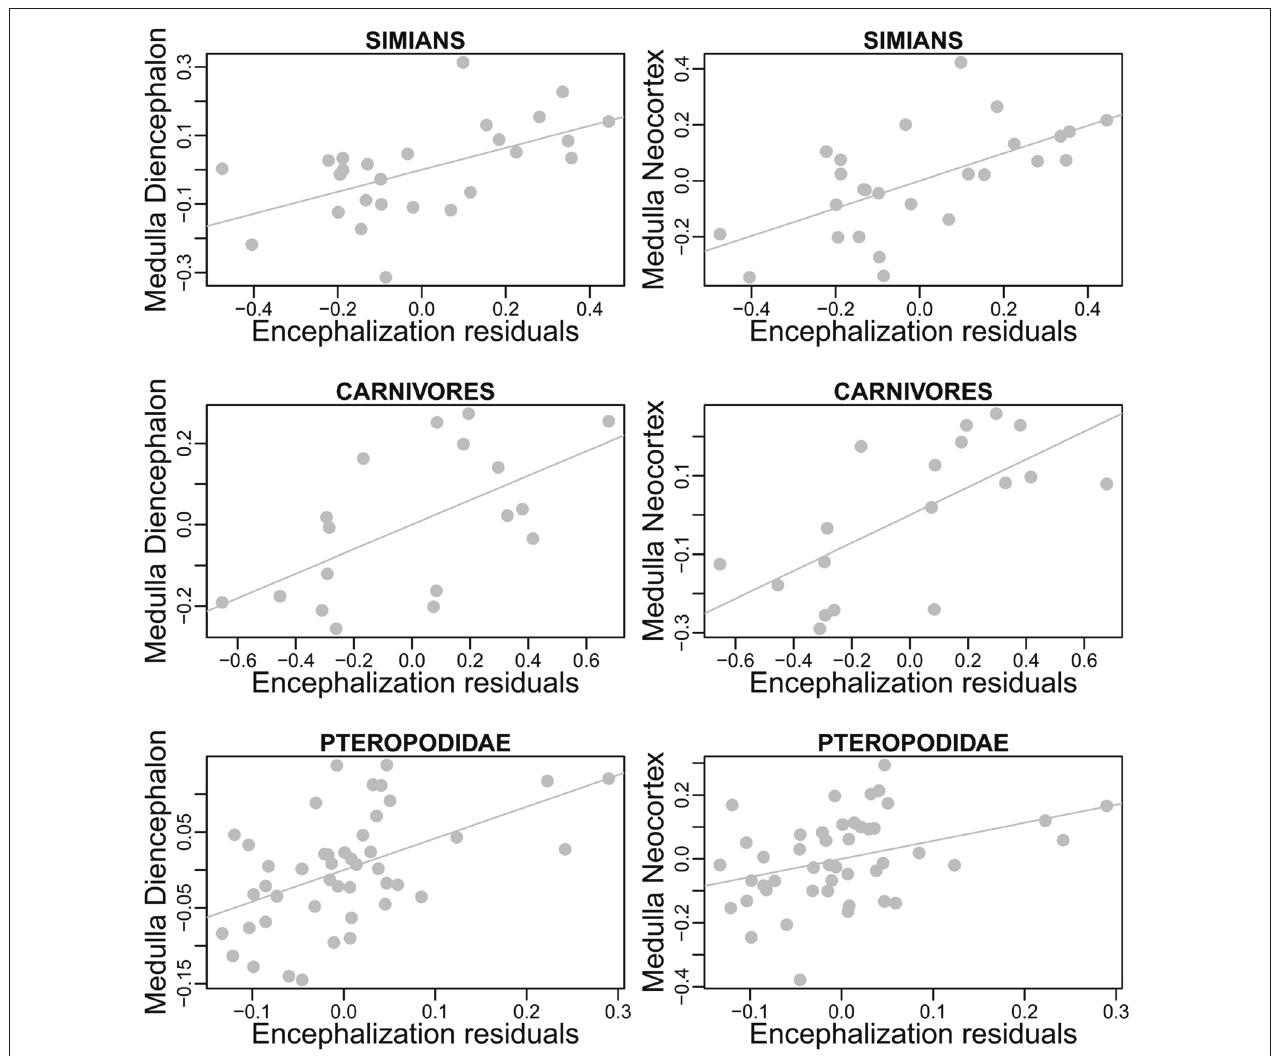
FIGURE 5 | Details from Table 2. Residuals from regressions of diencephalon (left) and neocortex (right) size onto the size of the medulla regressed onto encephalization